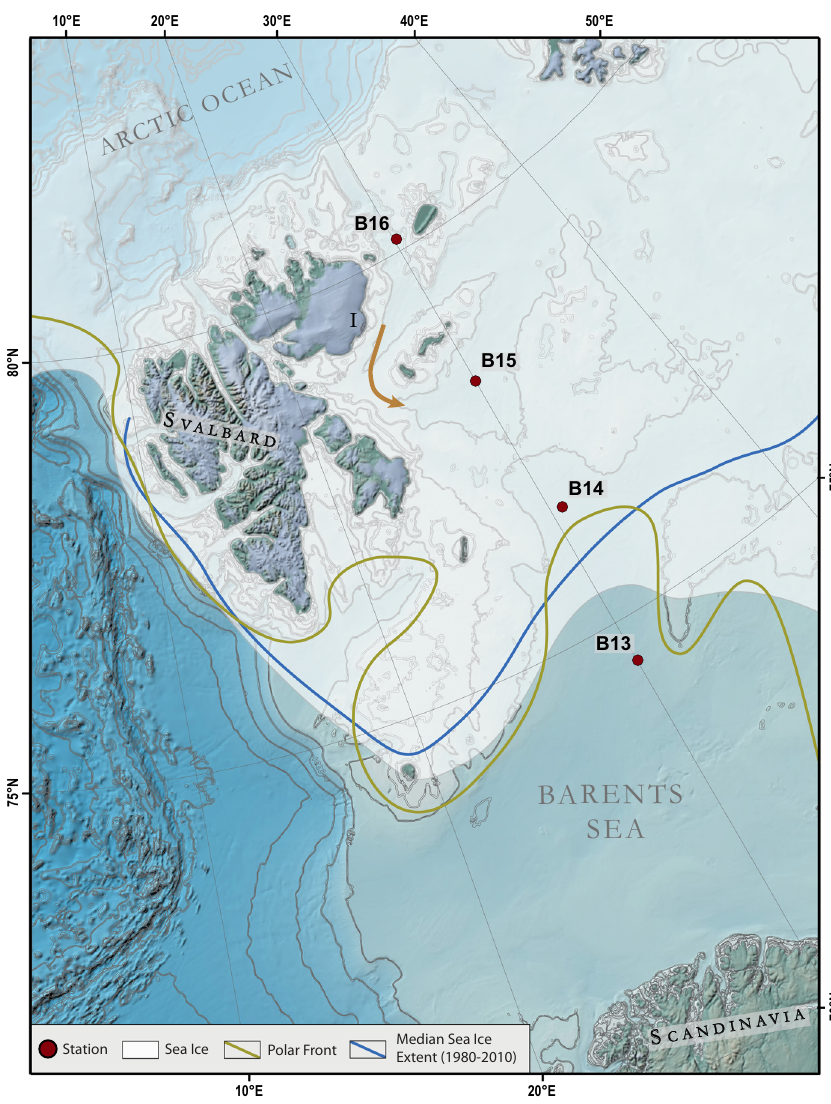
Fig. 1 Map of the study area and sampling stations. The Barents Sea is the largest pan-Arctic shelf sea covering an area of 1.6 million km 2 with an average water depth of 230 m 67 . There are several extensive overviews and reviews about the modern climate setting and ecosystem of the Barents Sea and we refer to these references for a detailed description of the physical and ecological conditions 34,68 – 72 . The general oceanic circulation pattern of the western Barents Sea is dominated by the relatively warm northward fl owing North Atlantic Current which enters the Barents Sea from the south-west and the southward fl owing cold Arctic currents entering the Barents Sea from the north-east. The relatively sharp boundary between these water masses forms the oceanographic Polar Front (golden line) 44 , which is mainly determined by the bathymetry and is, therefore, relatively stable from year to year 73 . The northern Barents Sea is seasonally ice covered with maximum and minimum ice coverage in March – April and August – September, respectively. The heat content of the Atlantic water keeps the southern Barents Sea permanently ice-free. River runoff into the Barents Sea is limited. Rivers on Svalbard and in Norway are small and often drain into fjords. Thus, sediment discharge through river in fl ow is low and the main processes responsible for the Barents Sea surface sediment distribution are re-deposition by winnowing from shallow banks into troughs and depressions and deposition from sea ice. Hence, sedimentation rates are generally low, 0.04 – 2.1 mm/y since the last glacial period 48 . The brown arrow indicates the proposed transport of iron-rich sediments from Nordaustlandet (I) into the central Barents Sea. The map was created using the IBCAO V. 3.0 dataset 74